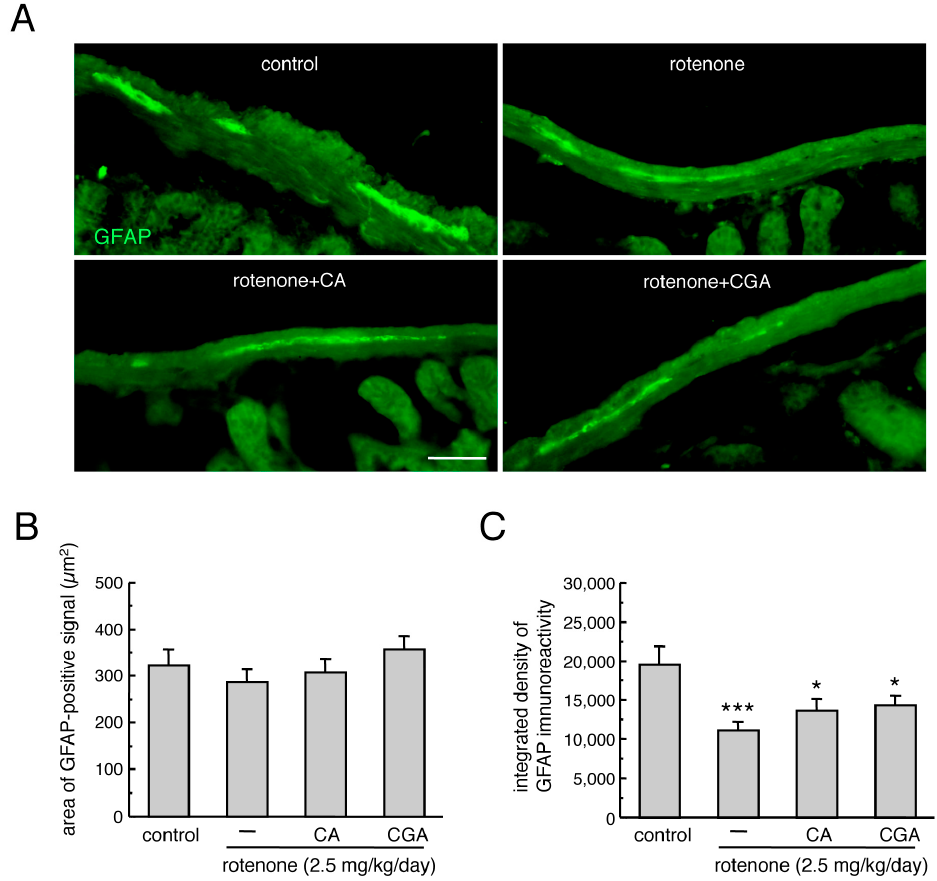
Figure 4. Effects of CA or CGA administrations on enteric glial cells in the intestines of rotenone-treated mice. ( A ) Representative photomicrographs of immunohistochemistry for GFAP in the intestines of rotenone-treated mice after treatment with CA (30 mg/kg/day) or CGA (50 mg/kg/day). Scale bar = 50 µ m. ( B , C ) Quantitation of GFAP-positive signals in the intestine of mice. ( B ) Area of GFAP-positive signal, ( C ) integrated density of GFAP immunoreactivity. Data are means ± SEM (n = 6–7). * p < 0.05, *** p < 0.001 vs. the vehicle-treated control group.